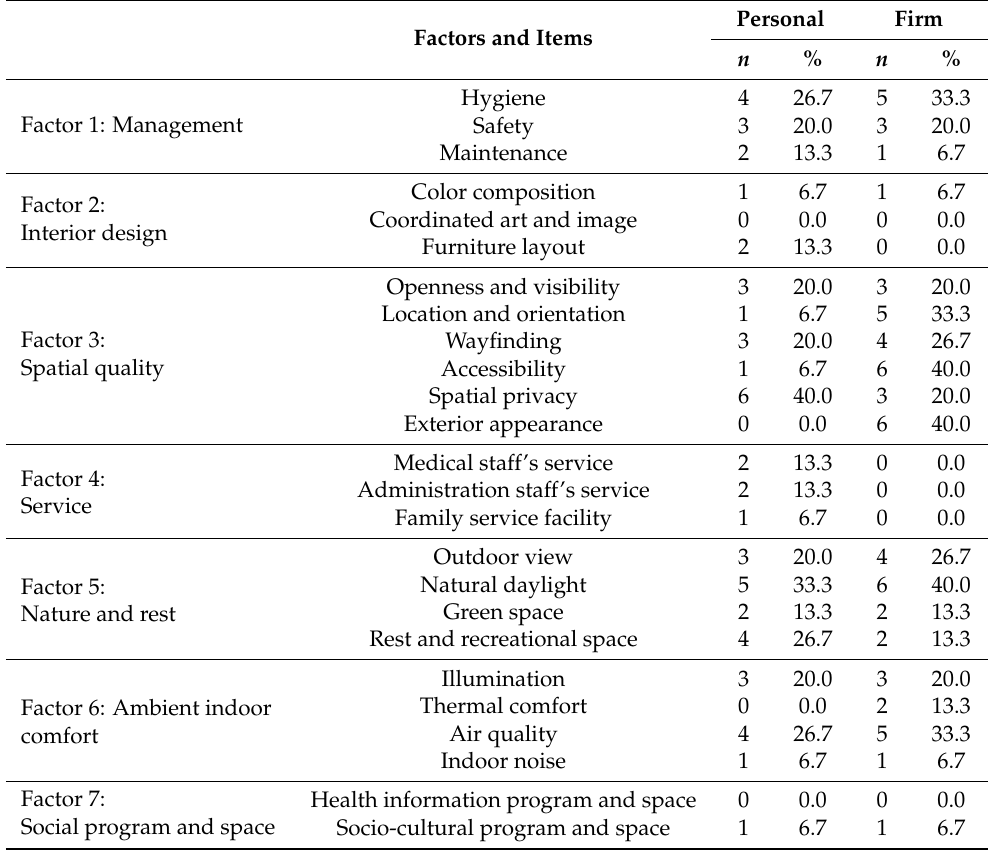
Table A1. Participants’ personal priority and firms’ priority in design implementation of the thera- peutic environmental